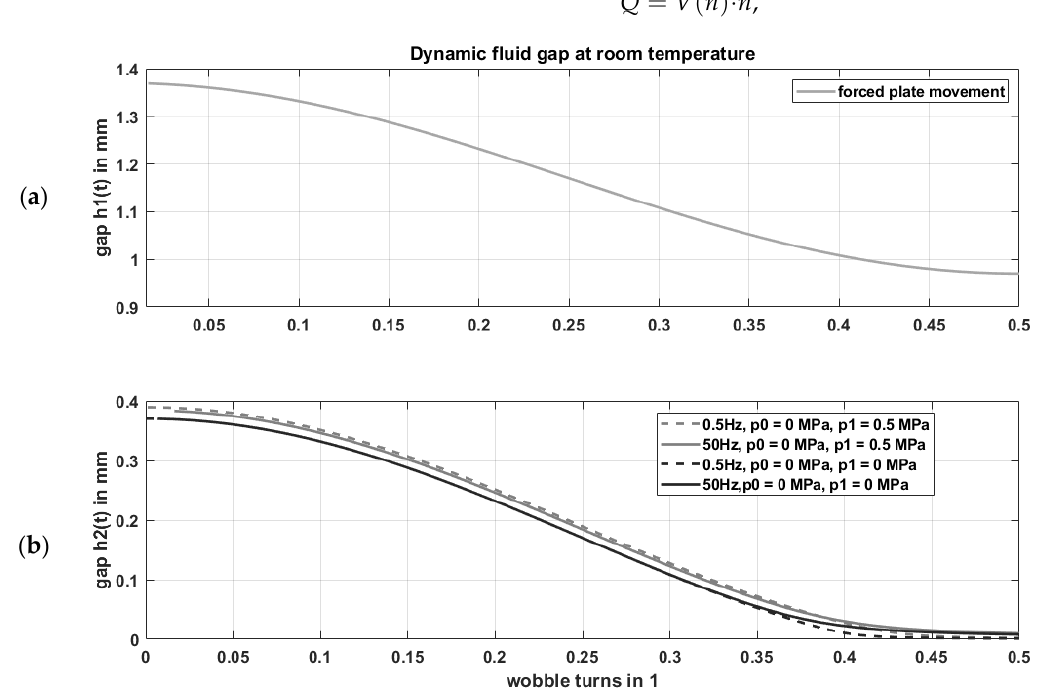
Figure 9. First simulation results of the dynamic fluid gap: ( a ): the forced fluid gap between wobble plate and cavity h1(t); ( b ): emerging fluid gap h2(t) due to different motor frequencies and load pressures.